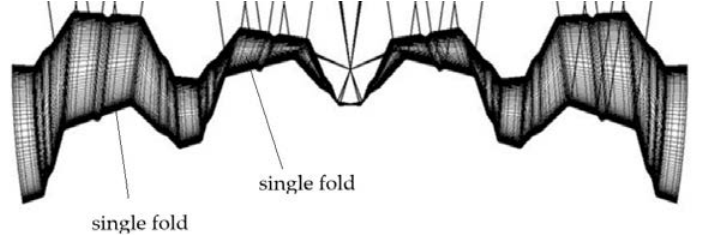
Figure 3. The accurate thin-walled computational mechanical model of a transformed sheet composed of four deformed shell